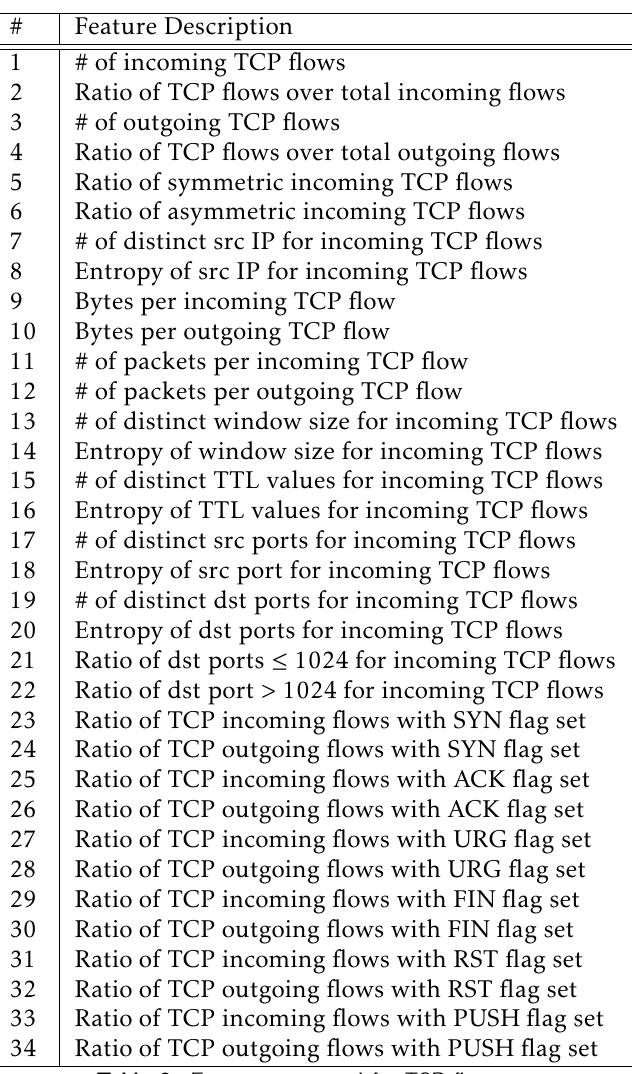
Table 2. Features extracted for TCP